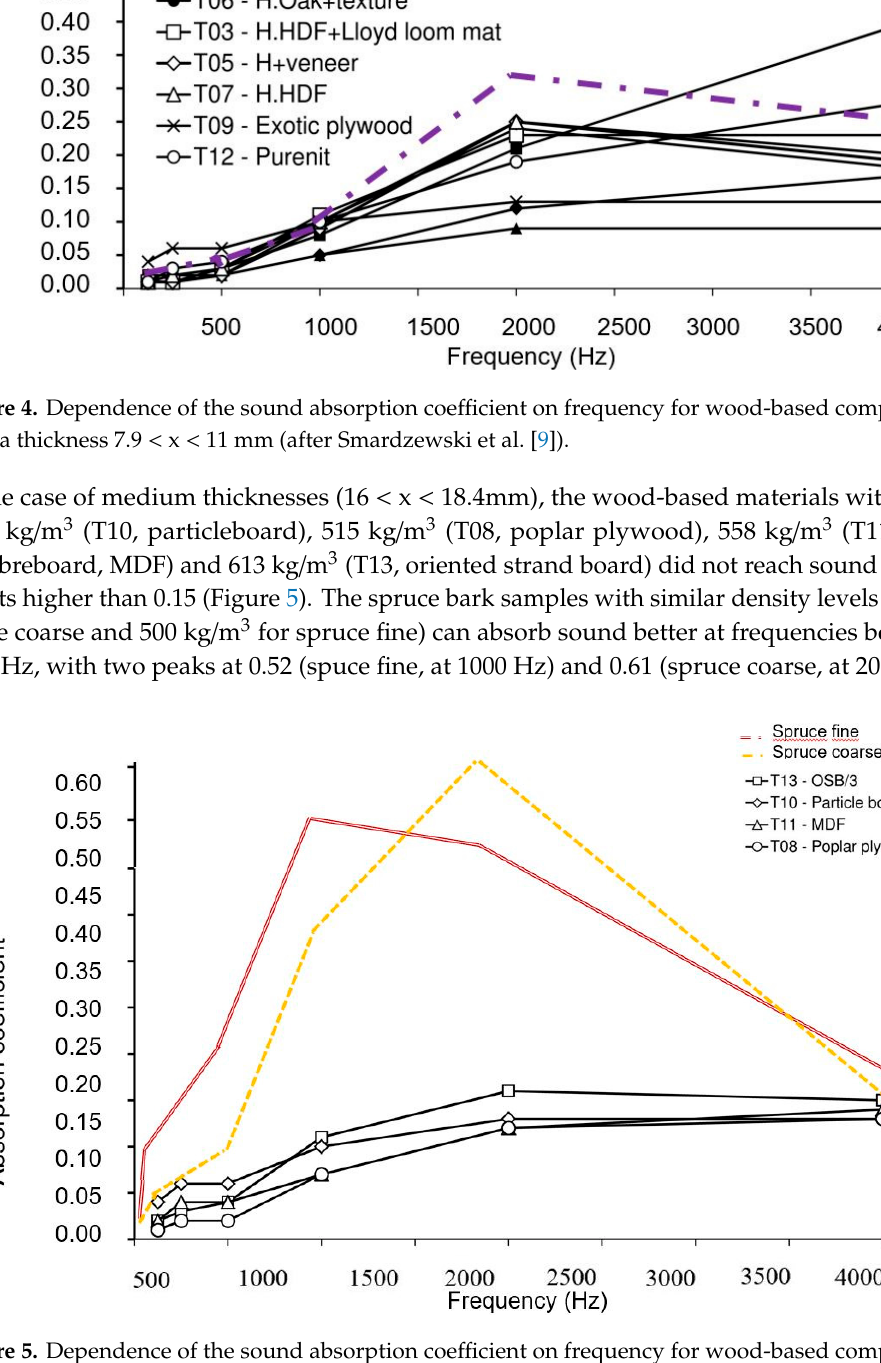
Figure 5. Dependence of the sound absorption coefficient on frequency for wood-based composites with a thickness 16 < x < 18.4 mm and a density 500 < y < 600 kg/m³ (after Smardzewski et al. [9]). For thickness interval 22.3 < x < 28 mm, the wood-based materials with densities that raged from 220 kg/m³ (T17, tubular particle board), 270 kg/m³ (T14, DendroLight—core), 459 kg/m³ (T15,